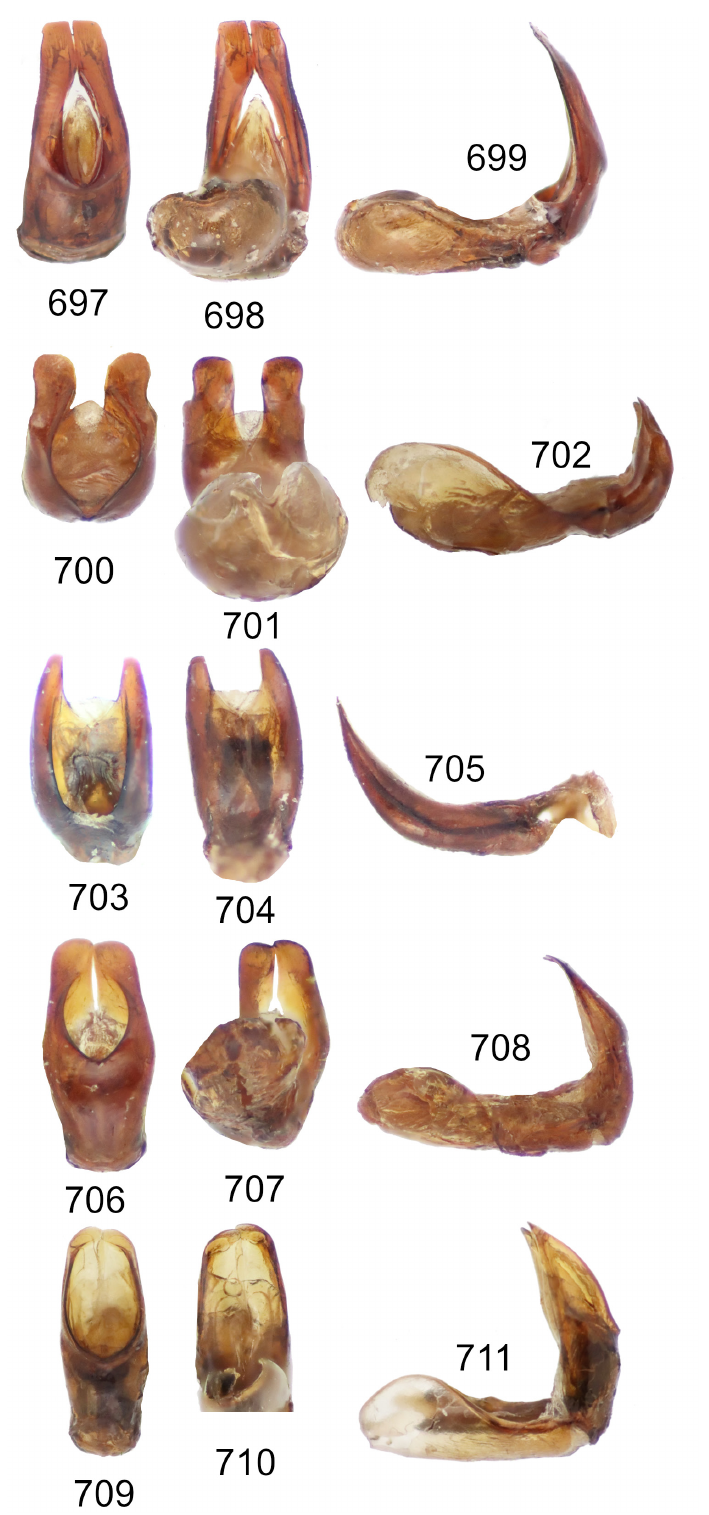
Figs 697–711. Papuan and Wallacean Maechidius Macleay, 1819, aedeagus, different aspects.